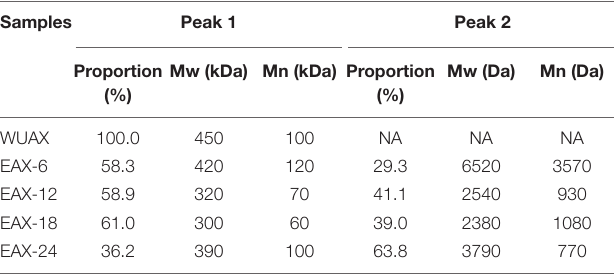
TABLE 1 | The molecular weight distribution of untreated and enzymatically hydrolyzed arabinoxylans. Samples